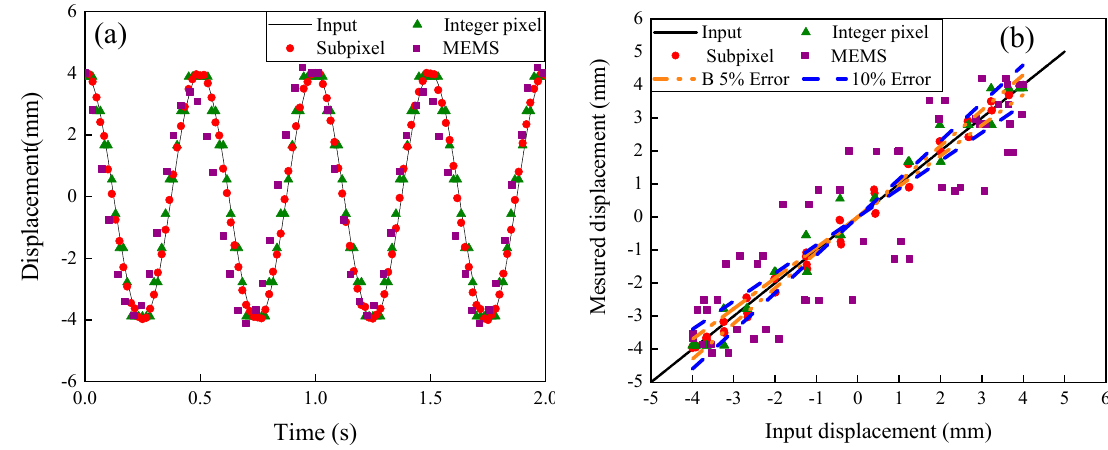
Figure 6. ( a ) Comparison of captured displacements with the input vibration with a frequency of 2 Hz and amplitude of 4 mm, and ( b ) Error analysis.